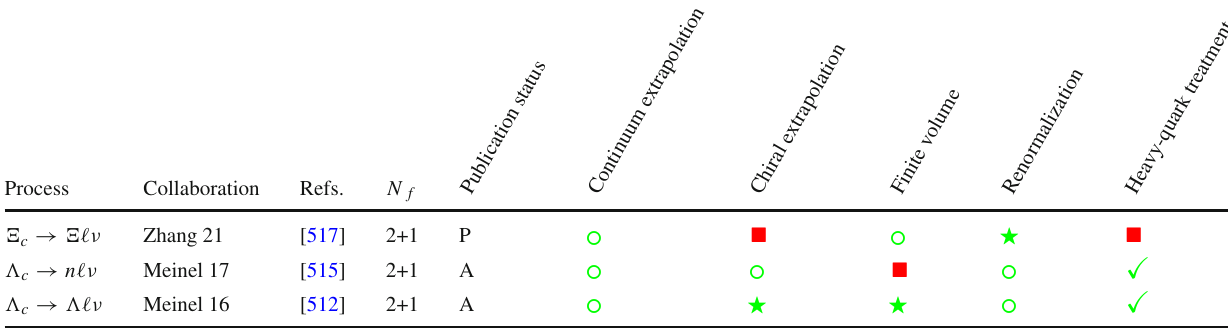
Table 37 Summary of computations of charmed-baryon semileptonic form factors